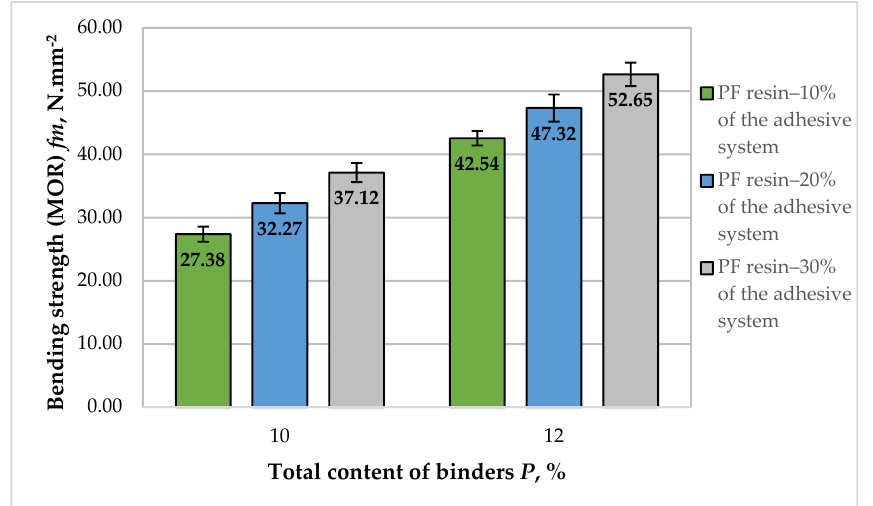
Figure 5. Bending strength (MOR) of fiberboard panels bonded with HL and PF resin.